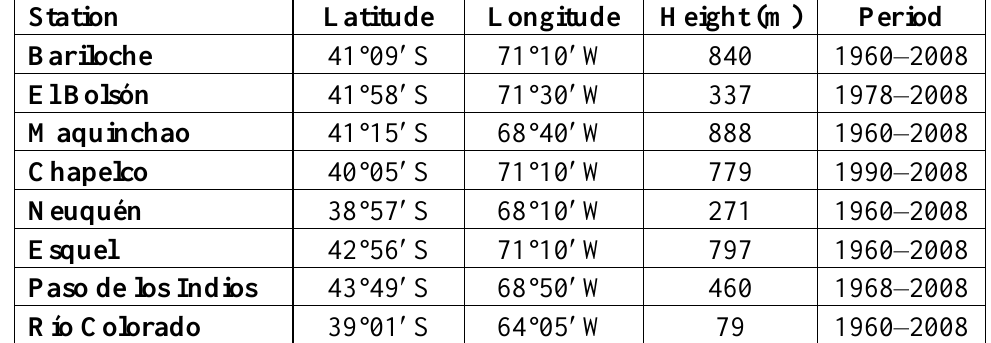
Table 2. Characteristics of the meteorological stations used for the precipitation analysis.